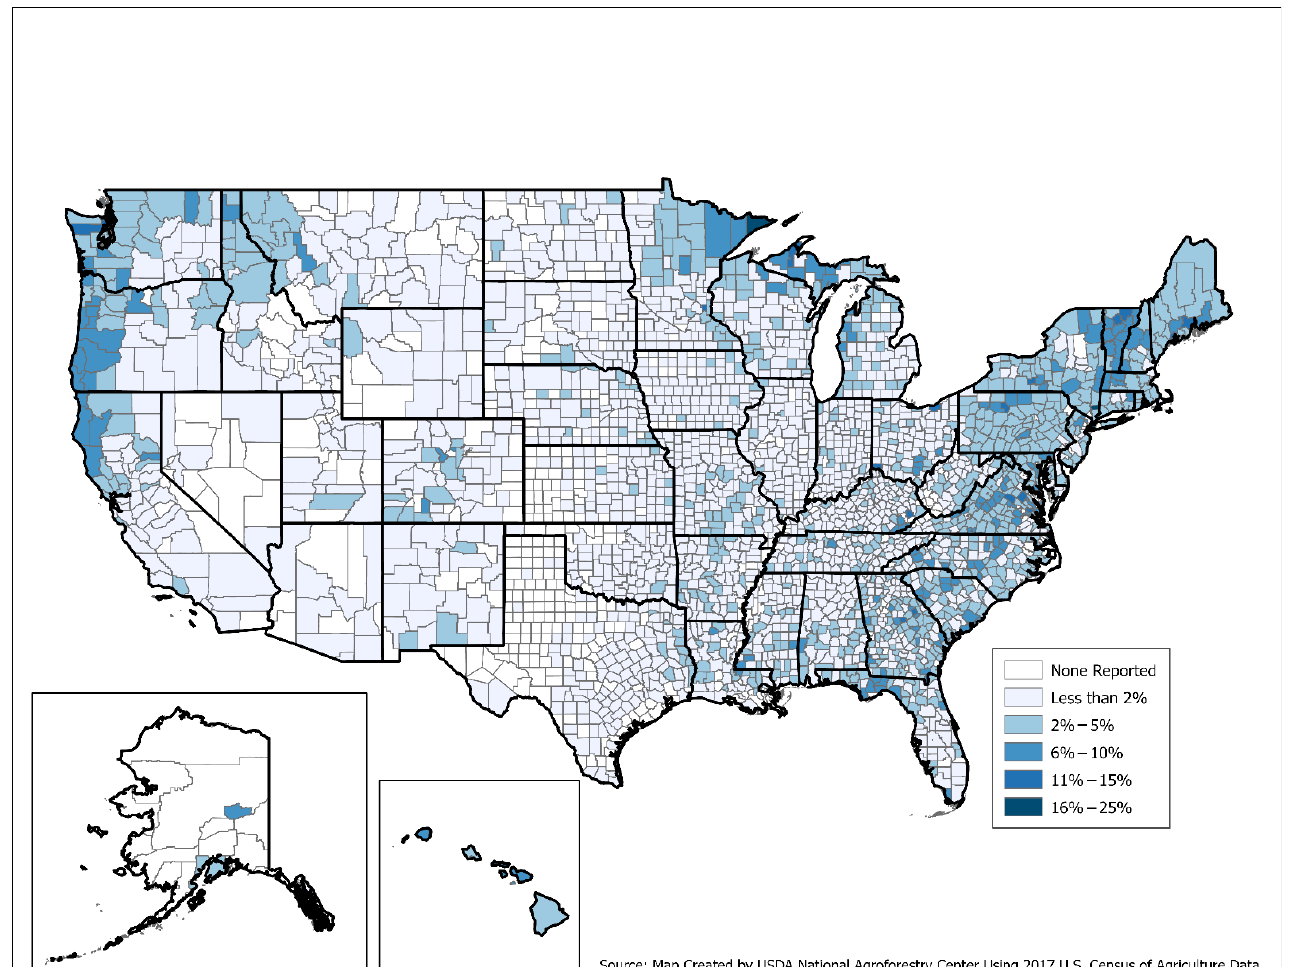
Figure 2. Percent of U.S. farms by county reporting using at least one of the five common agroforestry practices (windbreaks, riparian forest buffers, alley cropping, silvopasture, and/or forest farming) [17] .